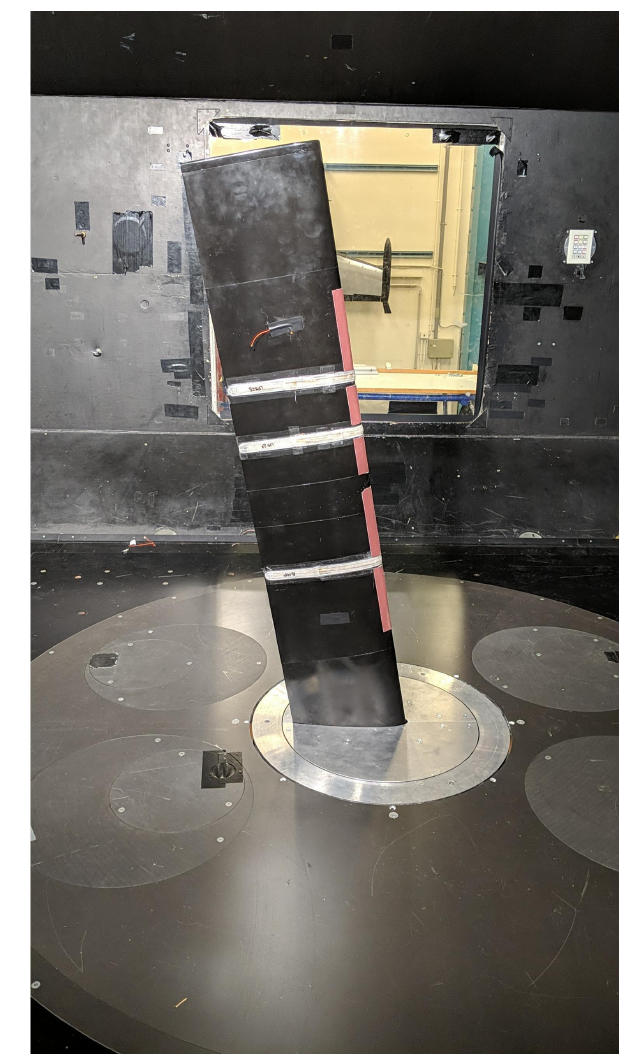
Figure 8. A 3D-printed NACA0018 blade installed in the test sec- tion of the ETH Zurich wind tunnel. The blade is in the 10 ◦ tilted configuration, with three barometer strips installed and sandpaper at the leading edge.